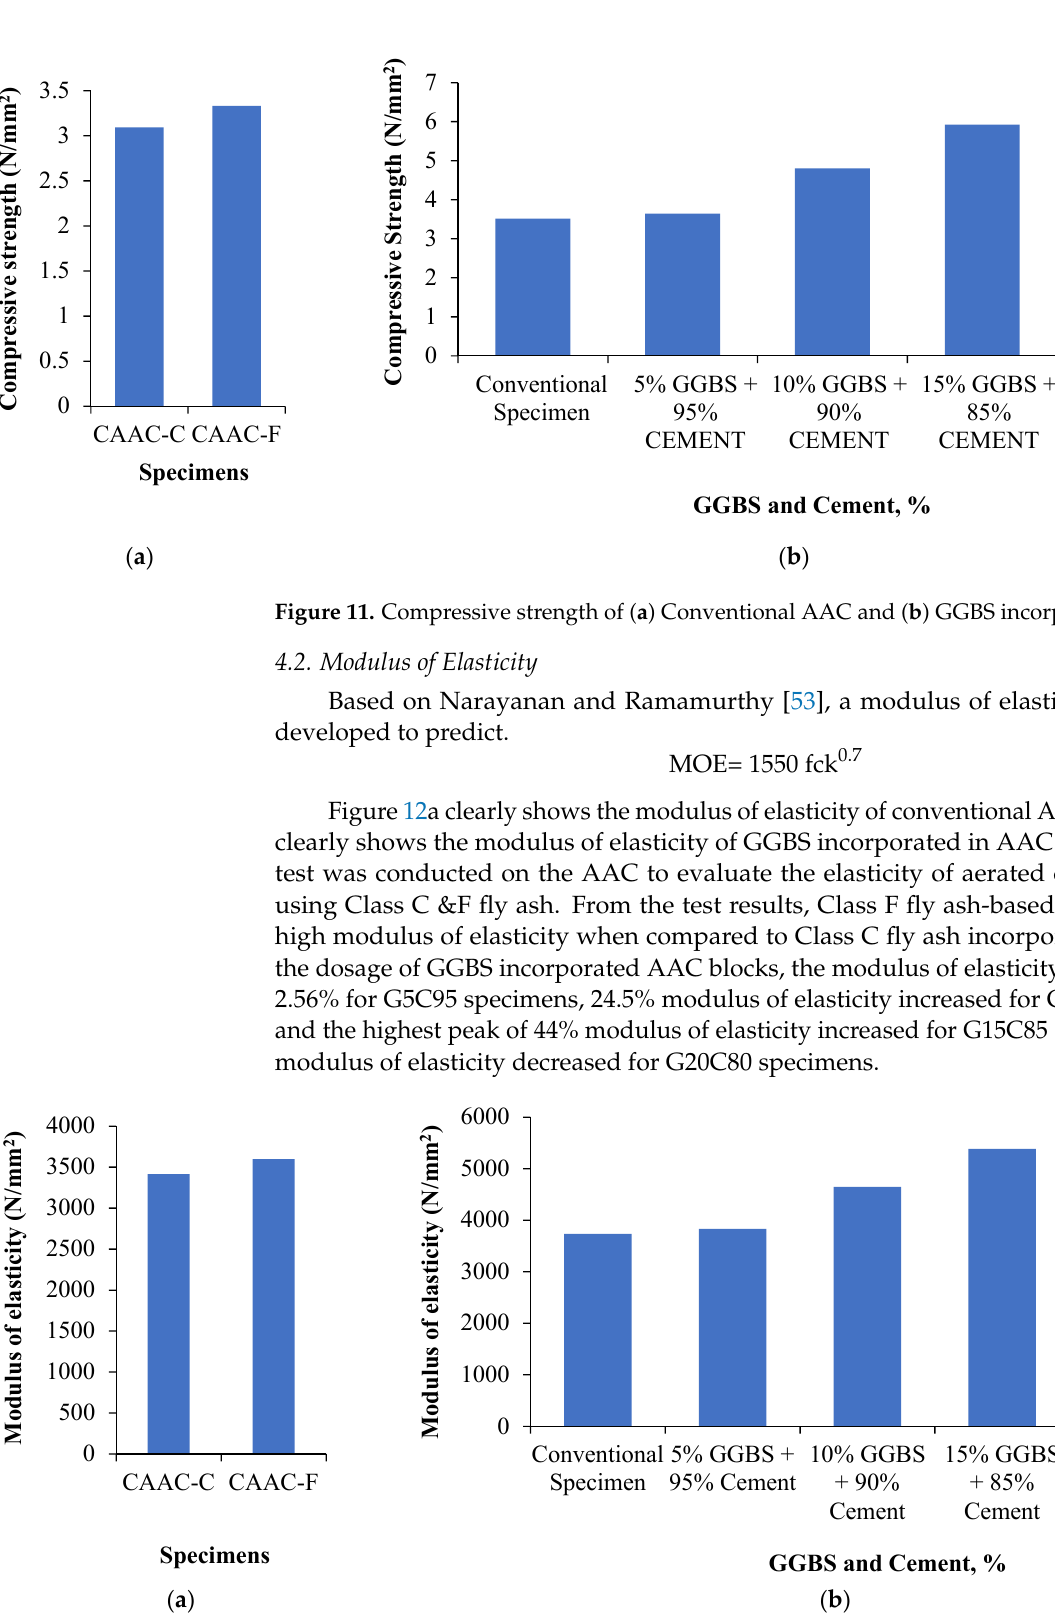
Figure 12. Modulus of Elasticity of ( a ) Conventional AAC and ( b ) GGBS incorporated in AAC.